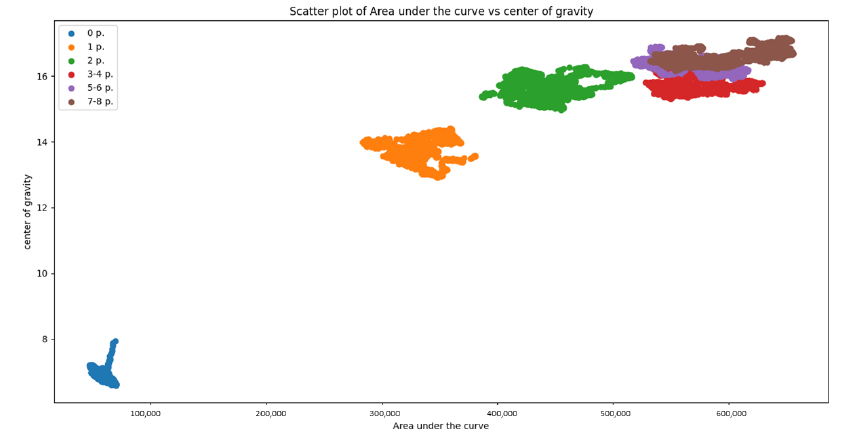
Figure 6. Scatter plot of the features Area under the curve vs. Center of gravity -for the different classes in Room B with maximum 8